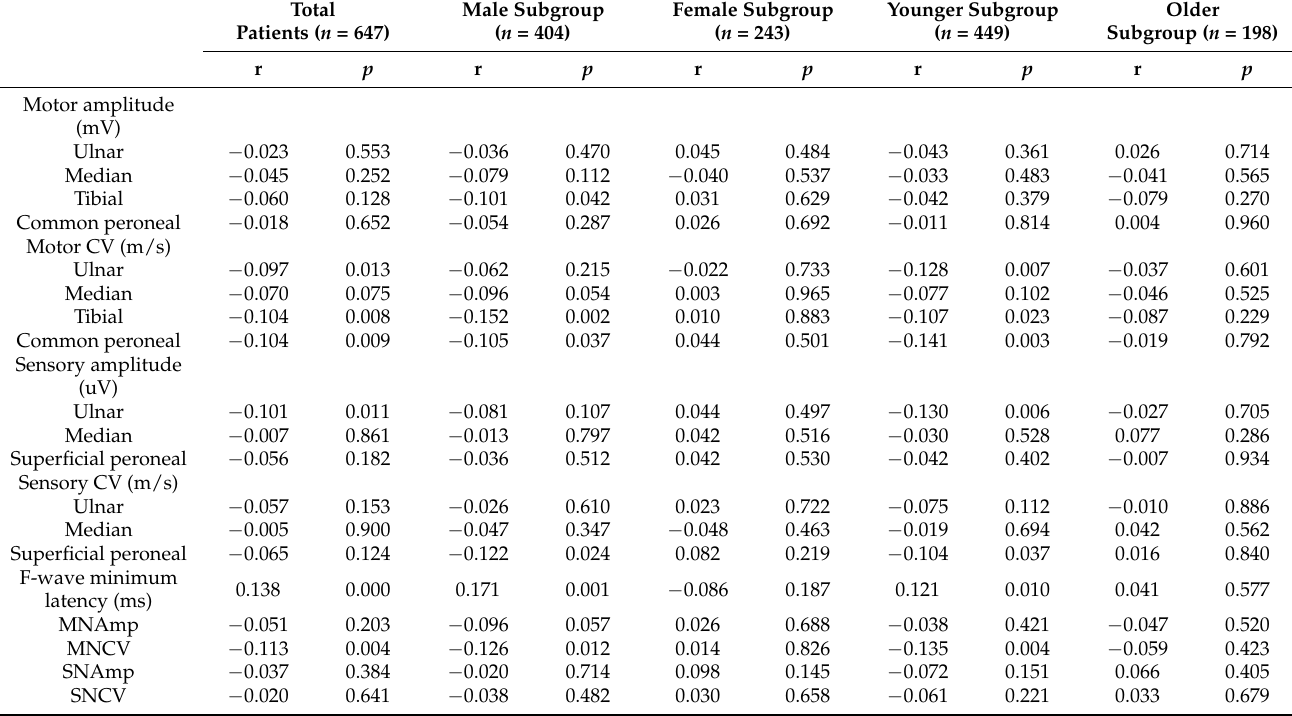
Table 5. Correlation analysis of serum uric acid (SUA) with nerve conduction studies parameters. Total Patients ( n =